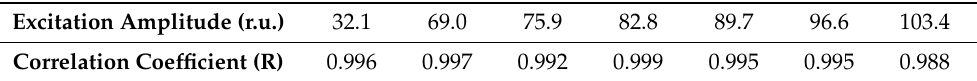
Table 2. Correlation coefficients between magnetic Barkhausen noise intensity value and stress at different excitation amplitudes of 120 Hz.